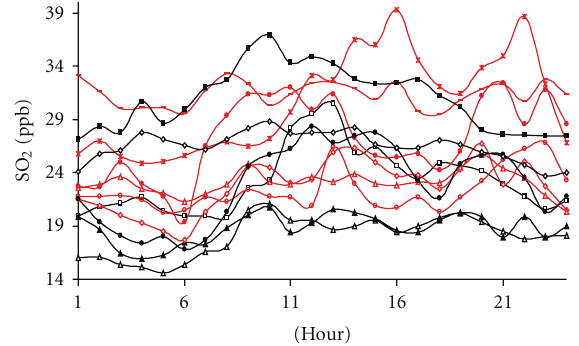
Figure 2: Diurnal pattern of SO 2 recorded over the period 2000- 2004 in Al-Mansoriah. Source: Al-Salem et al.